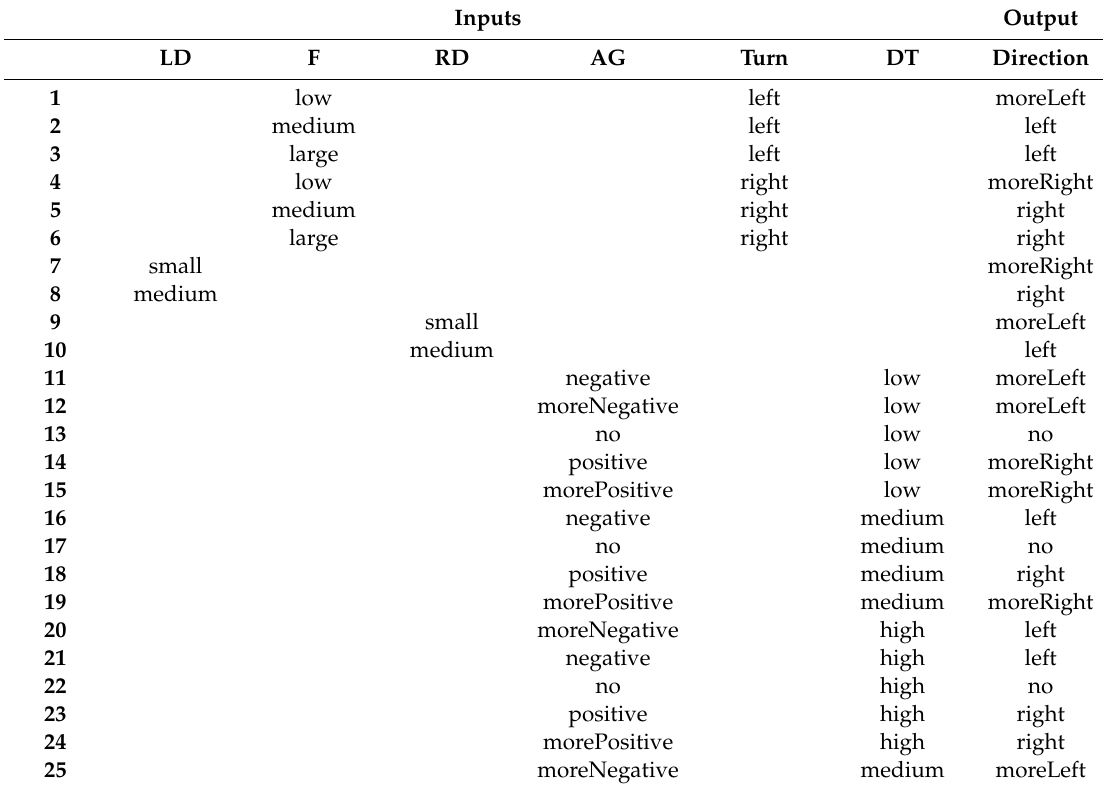
Table 1. Rule base for robot wheel speed fuzzy controller. Legend: LD, distance front left diagonal; F, distance front; RD, distance front right diagonal; AG, angle to goal; DT, distance to target.